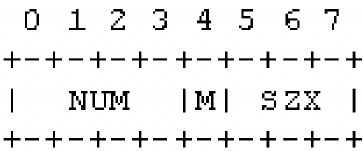
Figure 3. Encoding of the block